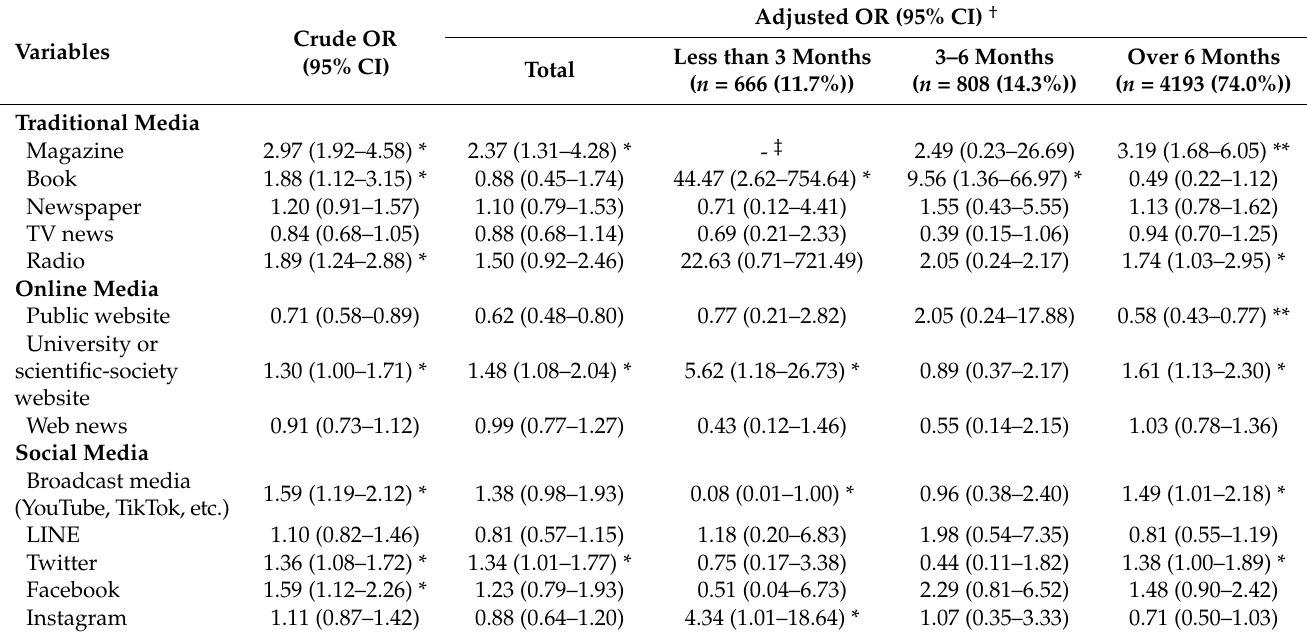
Table 2. Association between avoidance of child checkups and information source for